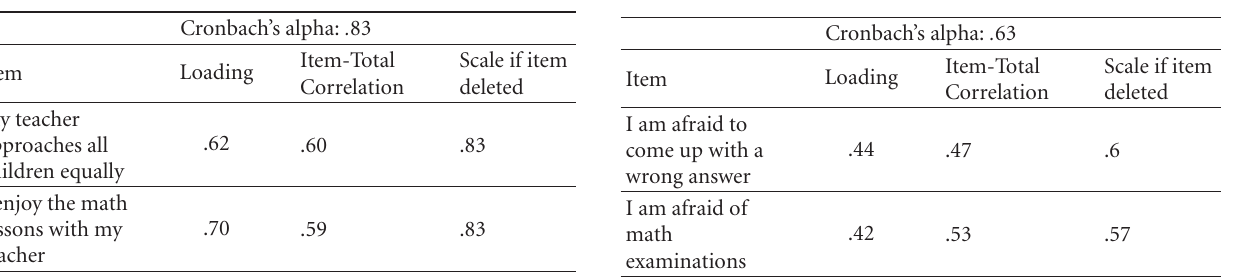
Table 1: Attitudes towards the teacher. Table 2: Mathematics anxiety.